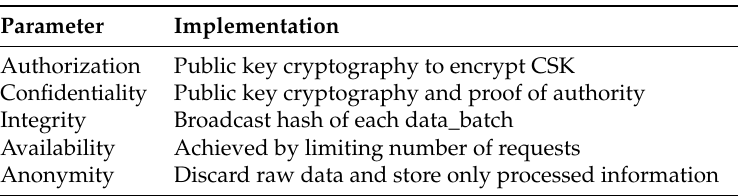
Table 2. Security